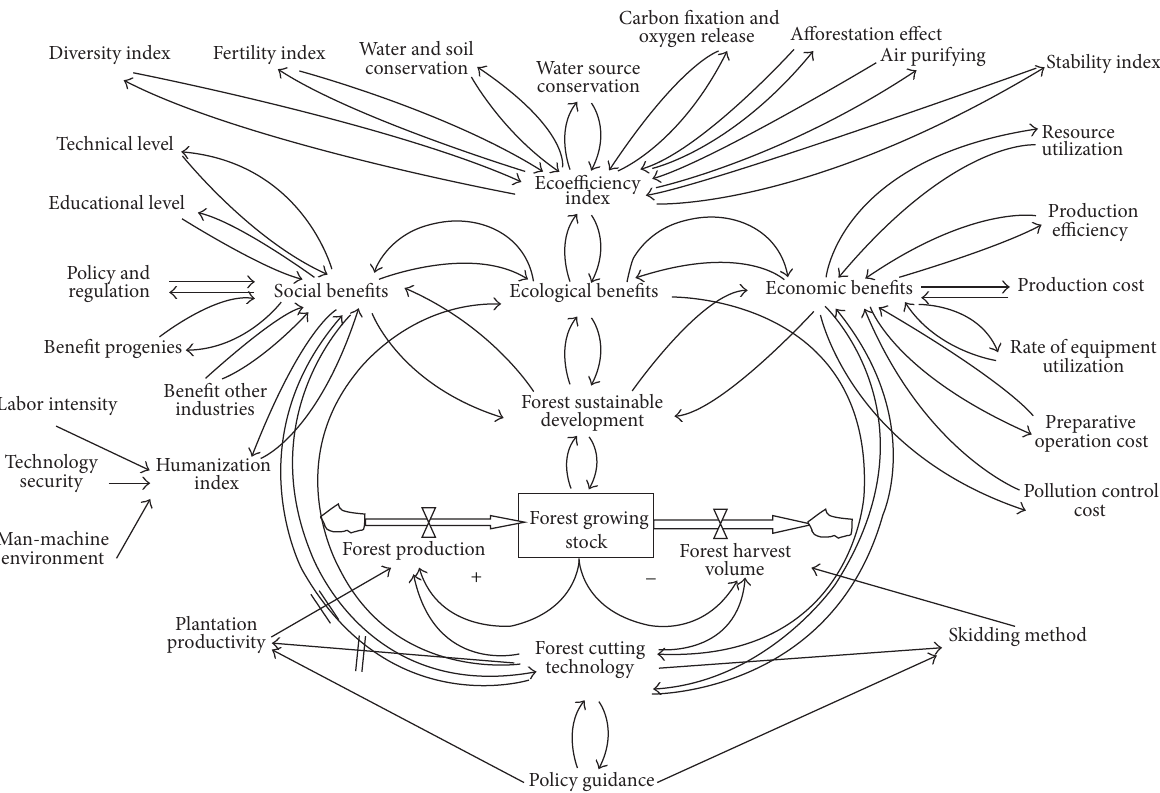
Figure 1: A causal power flow diagram showing the parameters and dynamics of sustainable deforestation